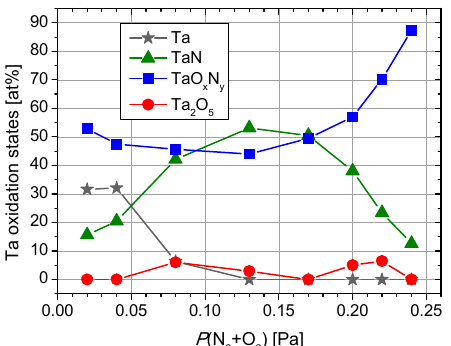
Figure 3. Tantalum chemical states relative concentrations based on the fitting process of Ta 4f XPS peak.